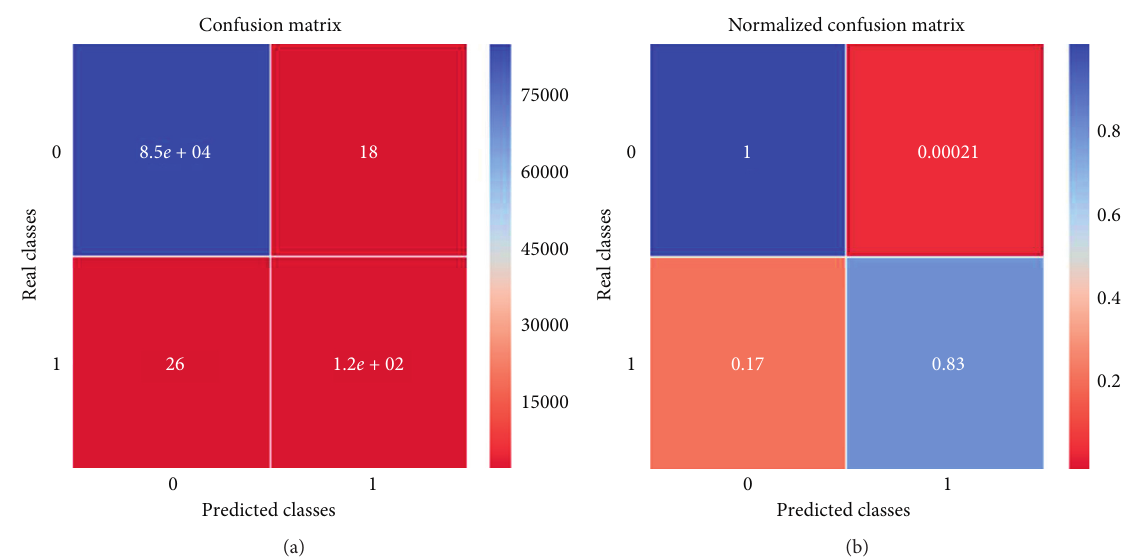
Figure 8: (a) Confusion matrix and (b) normalized confusion matrix for